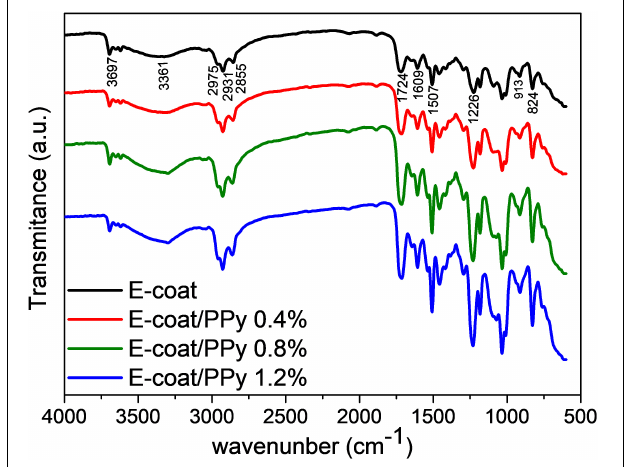
FIGURE 2 | SEM micrograph of PPy.